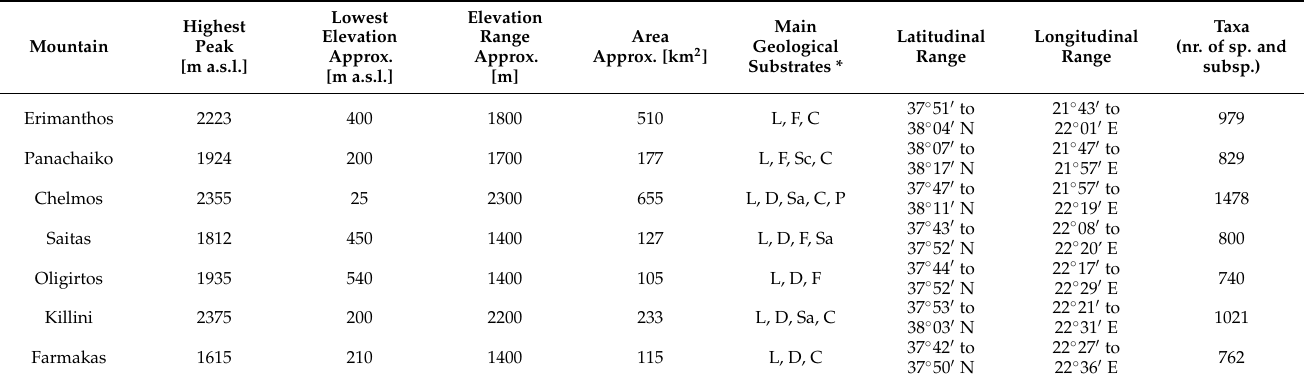
Table 6. Mountains included in comparative analyses of endemic plant taxa.